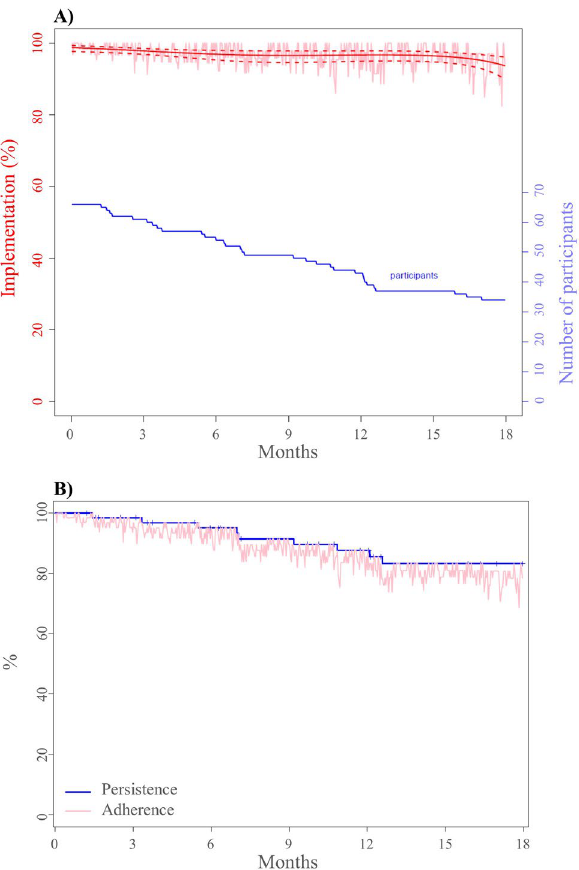
Figure 2. ( A ) Implementation among patients taking fingolimod and number of participants over 18 months, and ( B ) Persistence and adherence estimations among patients taking fingolimod over 18